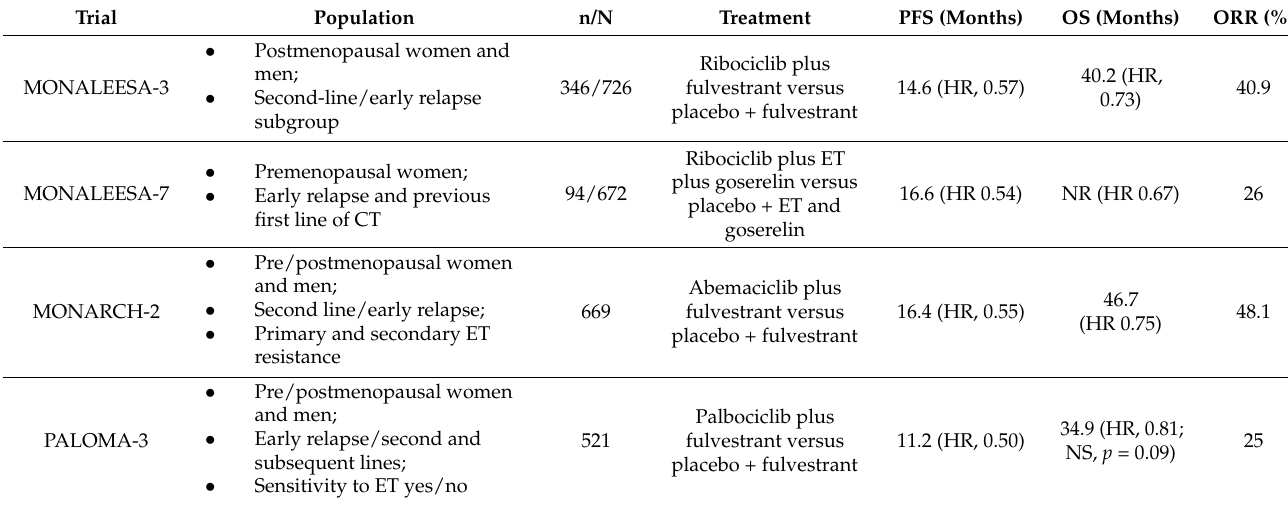
Table 2. Phase 3 trials of CDK4/6 inhibitors that included patients(n) in second-line and early relapse settings, in respect to the total populations enrolled